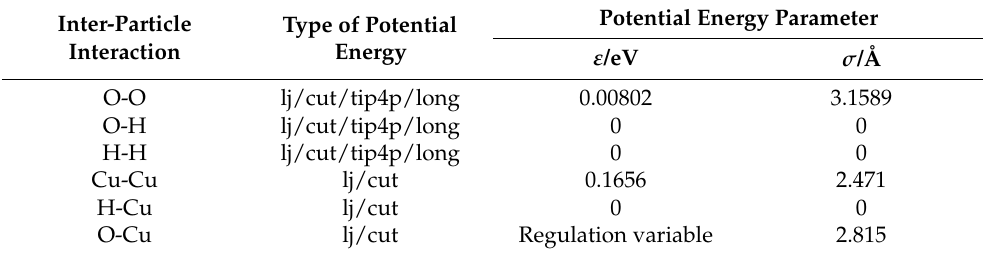
Table 1. Setting of potential energy